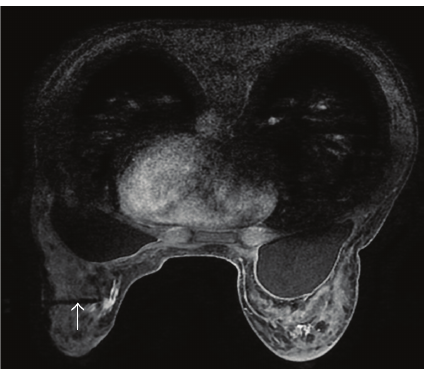
Figure 5: Axial postcontrast breast MRI in a patient who received silicone injection and mammoplastic bag placement shows a seg- mental enhanced lesion in left breast with a biopsy coaxial needle (white arrow) placed nearby. The biopsy diagnosis was